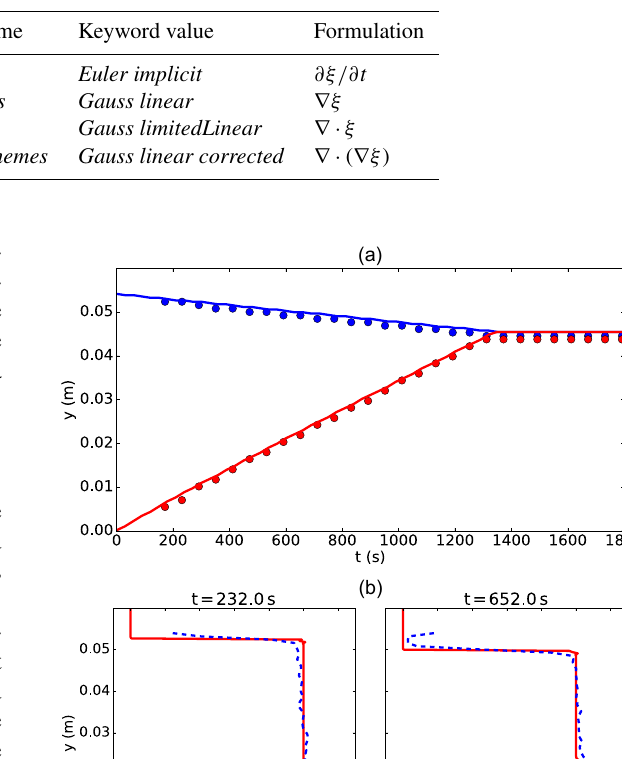
Table 8. Numerical schemes for each term in the momentum and mass conservation equations used in the validation test Sect. 4.1. ξ denotes a dummy variable for illustration purposes.